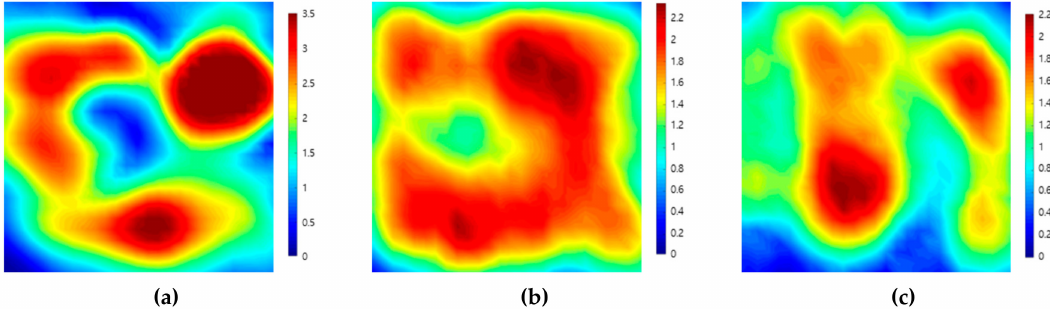
Figure 4. Ultrasonic images acquired by scanning the ( a ) top, ( b ) front, and ( c ) side planes of a coupon. Specimen using the first back-surface echo and the ultrasonic pulse-echo